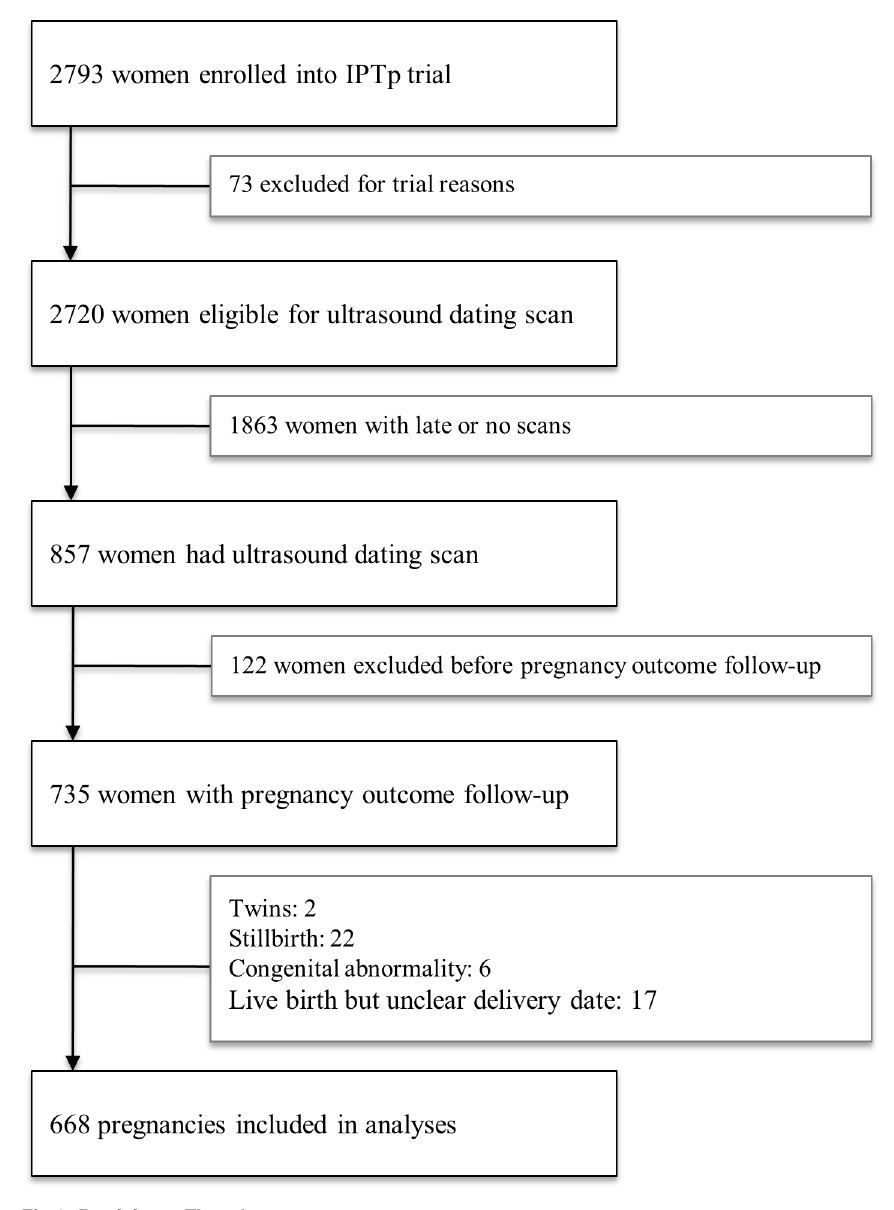
Fig 1. Participant